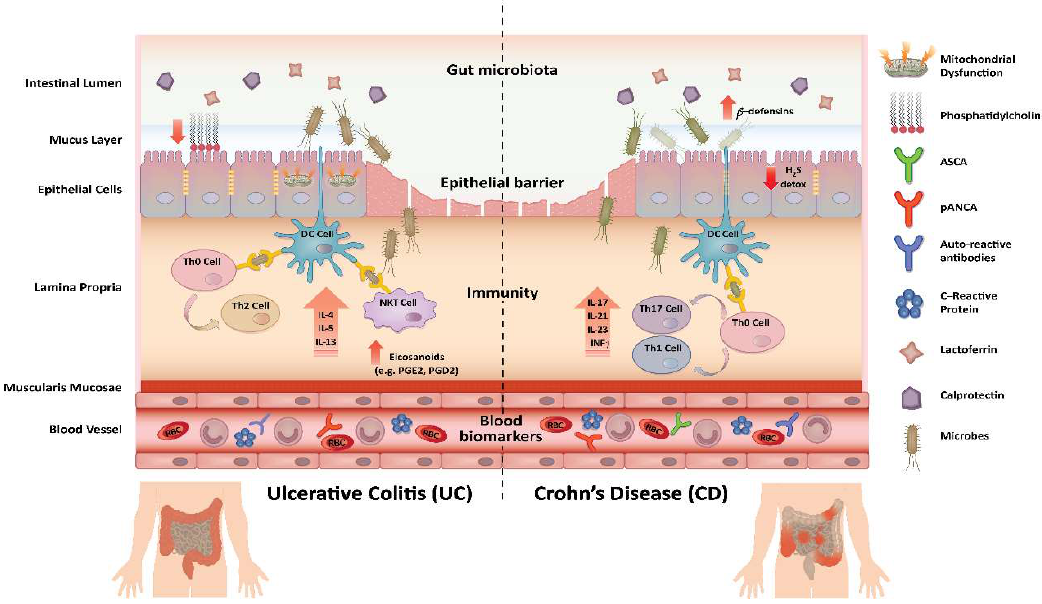
Figure 1. Pathomechanisms and selected biomarkers of IBD. The main pathogenesis-associated changes are shown for UC and CD. For both diseases, changes in gut microbiota, disruption of the epithelial barrier function, and chronic immune-activation are observed. Differences have also been reported, such as for immune-regulatory processes and epithelial effects. Biomarkers can be measured directly in tissue biopsies or upon release into the gut (e.g., fecal calprotectin) or the blood (e.g., autoreactive antibodies).